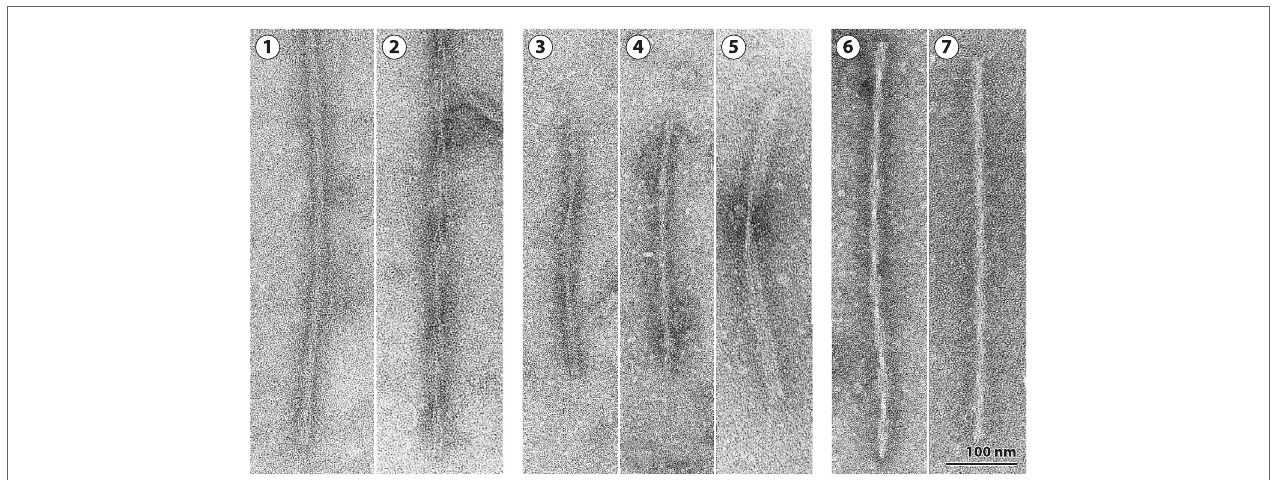
FigURe 2 | Tau filaments from FTDP-17T. [1,2] Neuronal Tau filaments from a case with abundant Pick body-like inclusions and a G389R mutation in MAPT (66). [1] Straight filaments form the majority species and [2] strongly stranded twisted filaments are in the minority. [3–5] Tau filaments from cases with neuronal and glial inclusions and a P301L mutation in MAPT or an intronic mutation [from Ref. (67, 68)]. [3] Narrow twisted ribbons and [4] occasional rope-like filaments. [5] Familial multiple system Tauopathy with presenile dementia and other cases caused by MAPT mutations in the intron after E10 are characterized by wide twisted ribbons and neuronal and glial Tau inclusions. The filaments in [3–5] are made of 4R Tau. [6,7] Tau filaments from a case with a V337M mutation in MAPT [from Ref. (69)]. [6] Paired helical and [7] straight filaments are present as in Alzheimer’s disease. Tau inclusions are largely neuronal, and filaments in [6] and [7] are made of 3R and 4R